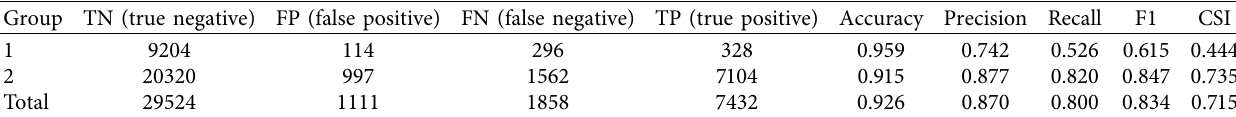
Table 8: Results with XGBoost by group using weather, geographic, and frost (a day before)